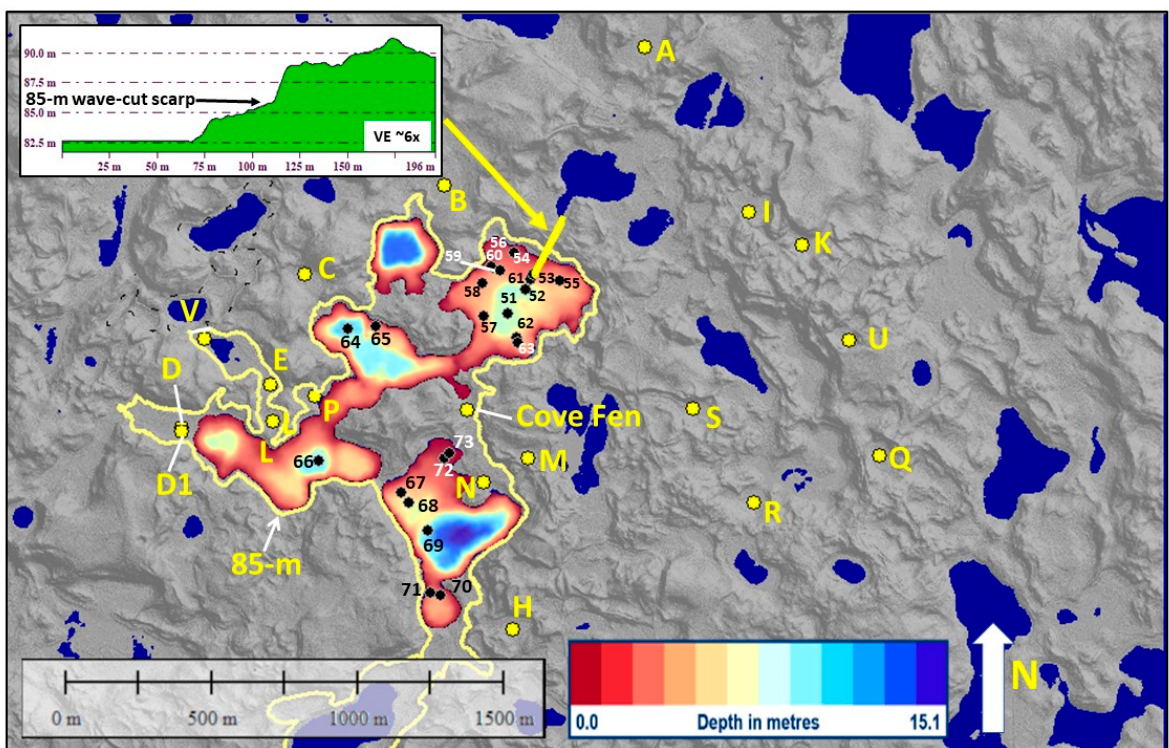
Figure 2. Jigsaw Lake shown in a bare-earth LiDAR image, with peat coring locations in satellite fens and the surrounding Moosehorn moraines (yellow dots); lake sediment core locations are numbered dots within the lake basin. The yellow 85 m asl contour follows the wave-cut scarp of the ancestral lake basin.